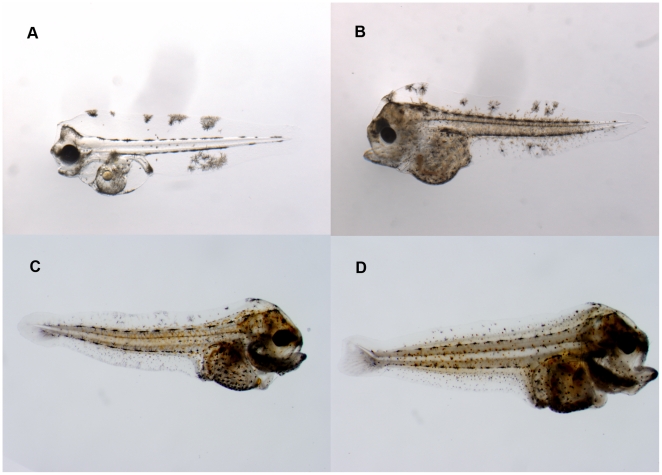
The larval stages of common sole (Solea solea) that were used in the experiments.The photos show a stage 1 larva of 5.3 mm (A), a stage 2 larva of 6.0 mm (B), a stage 3 larva of 6.5 mm (C) and a stage 4a larva of 7.1 mm (D).